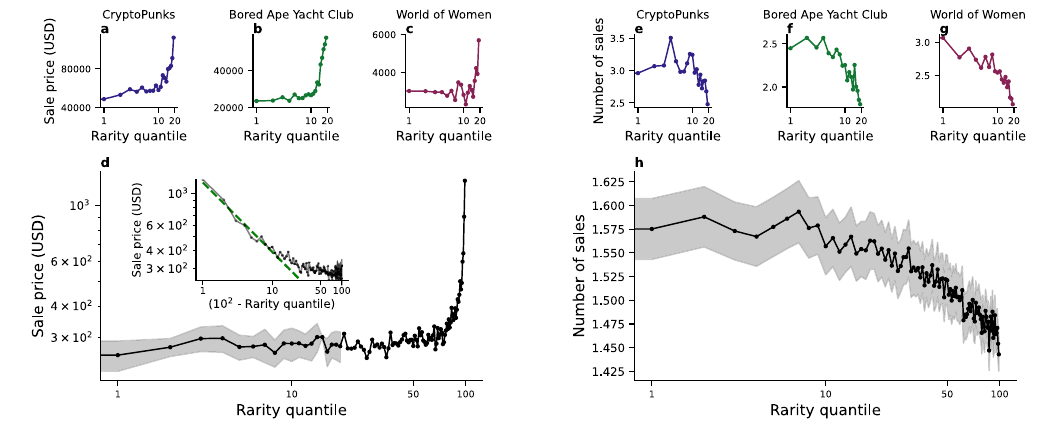
Figure 6. Rare NFTs have a higher financial value and circulate less on the marketplace. Median sale price in USD ( a–c ) and average number of sales ( e–g ) by rarity quantile (with 20 quantiles considered) for three collections: CryptoPunks ( a, e ), Bored Ape Yacht Club ( b, f ), and World Women ( c, g ). ( d ) Median sale price by rarity quantile (with 100 quantiles considered) considering all collections. Inset: median sale price against the quantity (100- q ), where q is the rarity quantile, in log-log scale (black line) and the corresponding power law fit (green dashed line). ( h ) Median number of sales by rarity quantile considering all